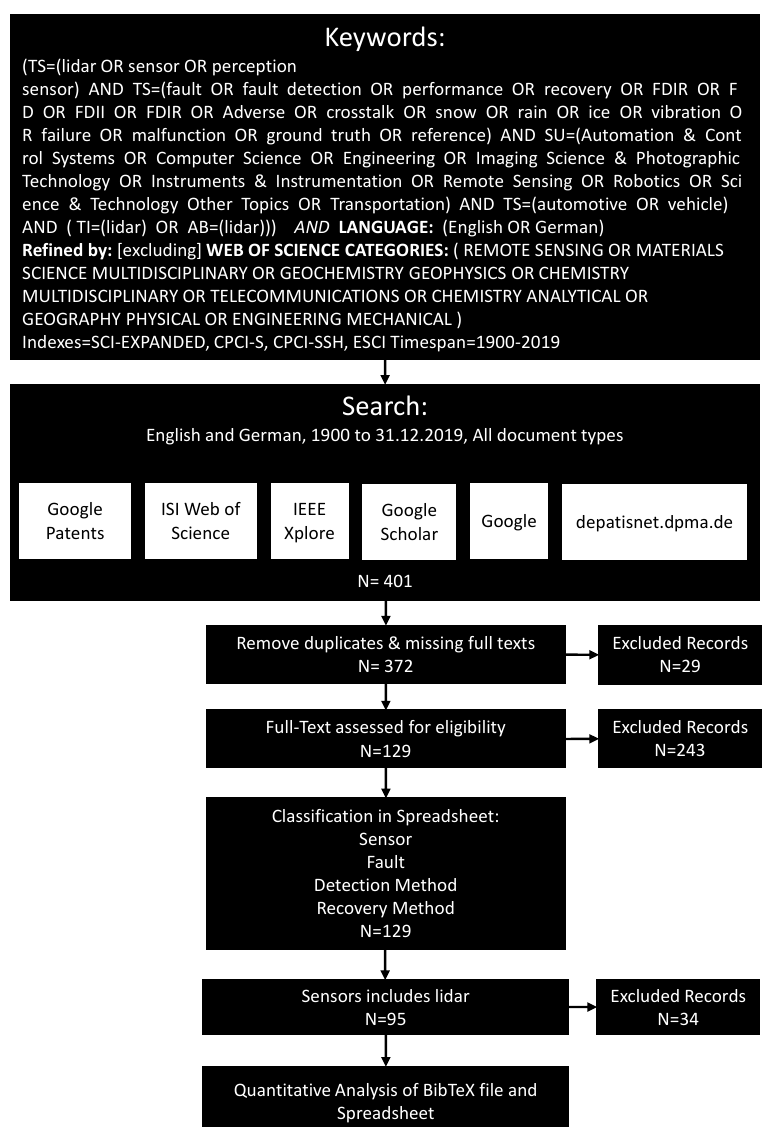
Figure 4. Review process for FDIIR methods of automotive lidar